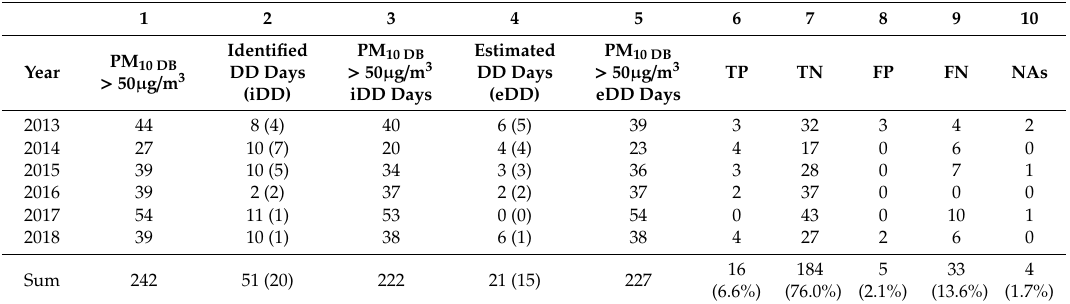
Table 4. Column 1: Amount of days of PM 10 exceedance at DB, Column 2: Identified desert